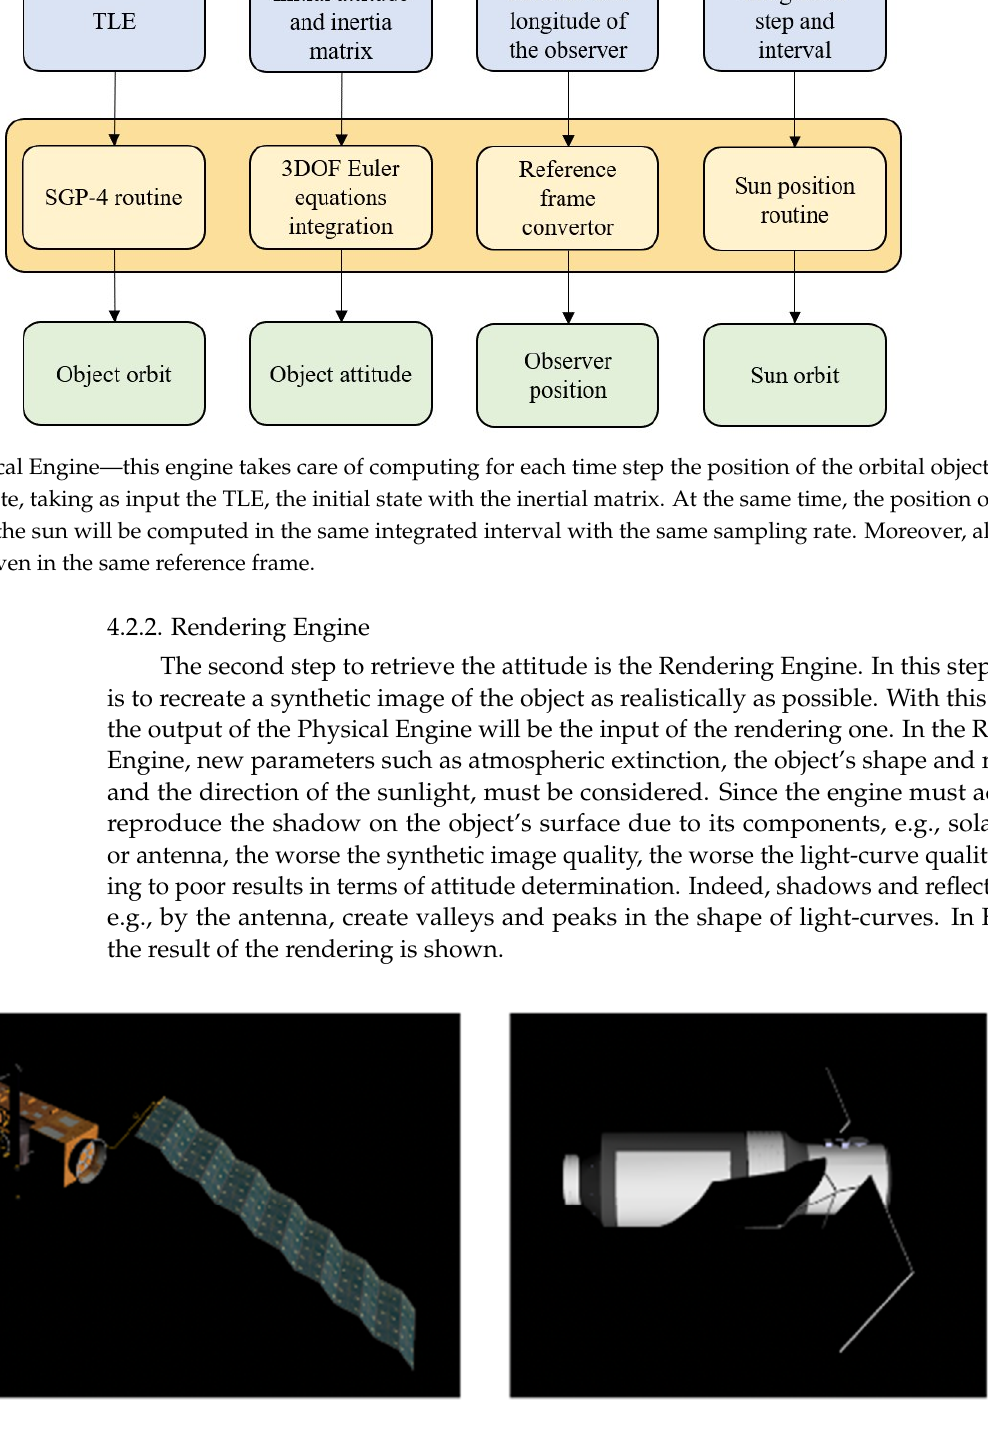
Figure 17. Rendered images—this figure shows the result of the rendering engine on the 3D model of the Tiangong-1 and Envisat with shadow [https://sketchfab.com/].